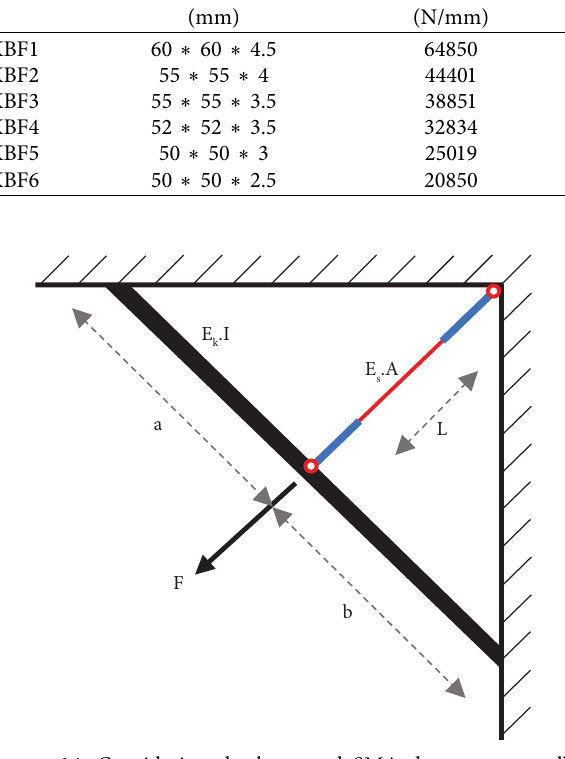
Figure 14: Considering the knee and SMA damper as parallel springs.